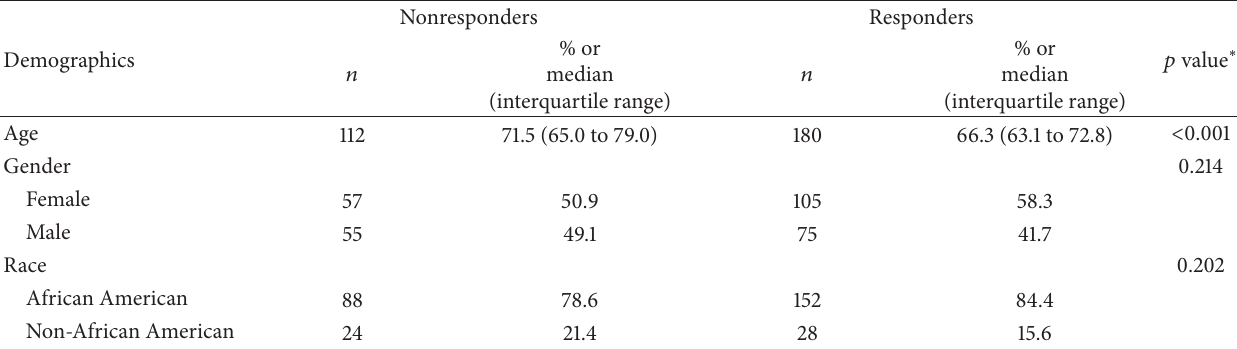
Table 2: Stage 2 responders and nonresponders by sociodemographic